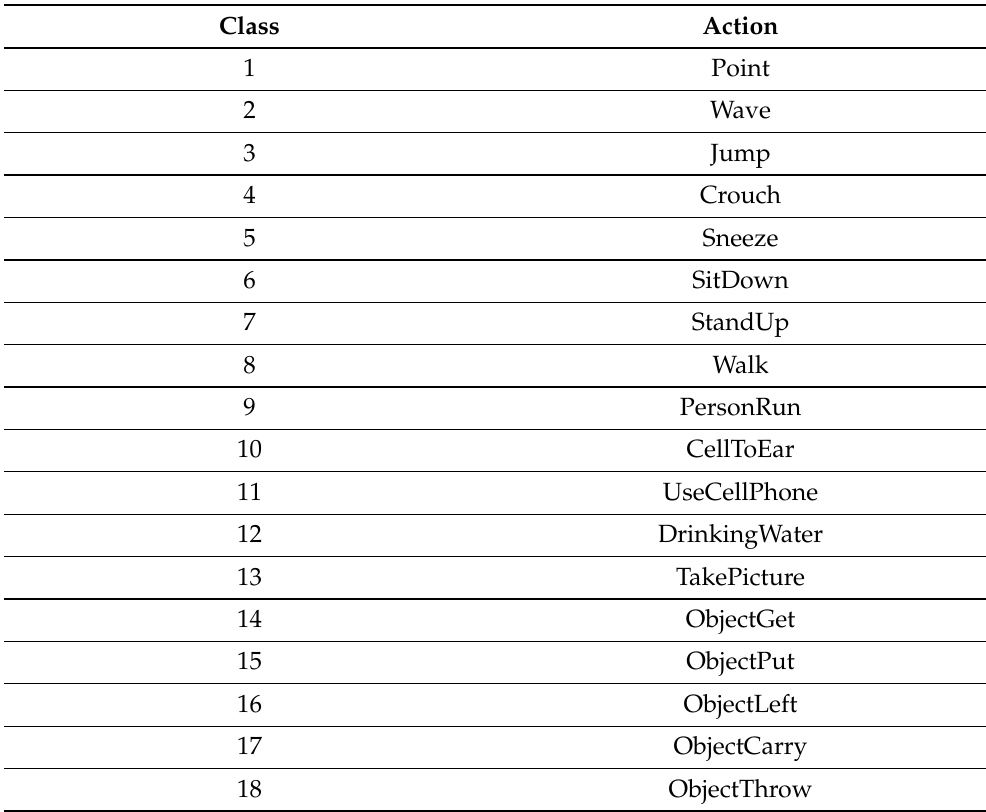
Table 2. List of actions from MCAD